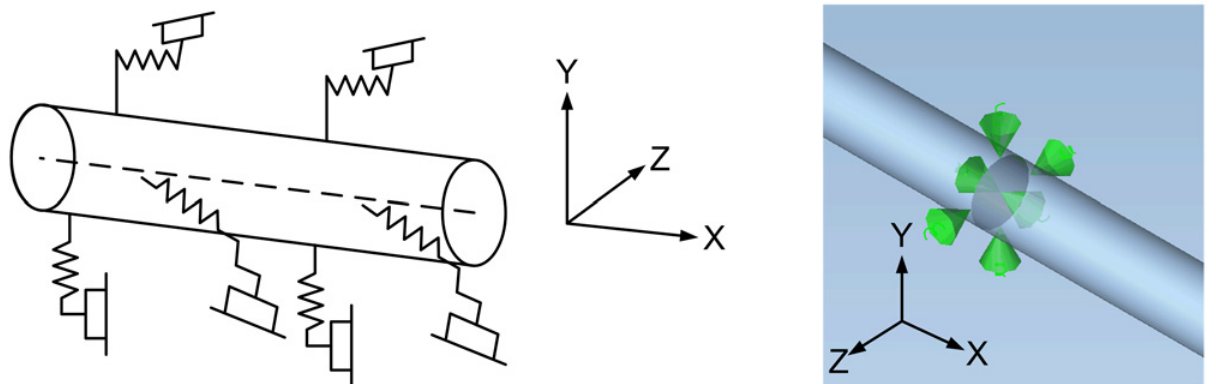
Fig 4. Soil model. (A) Soil Constraints and (B) soil numerical simulation model.